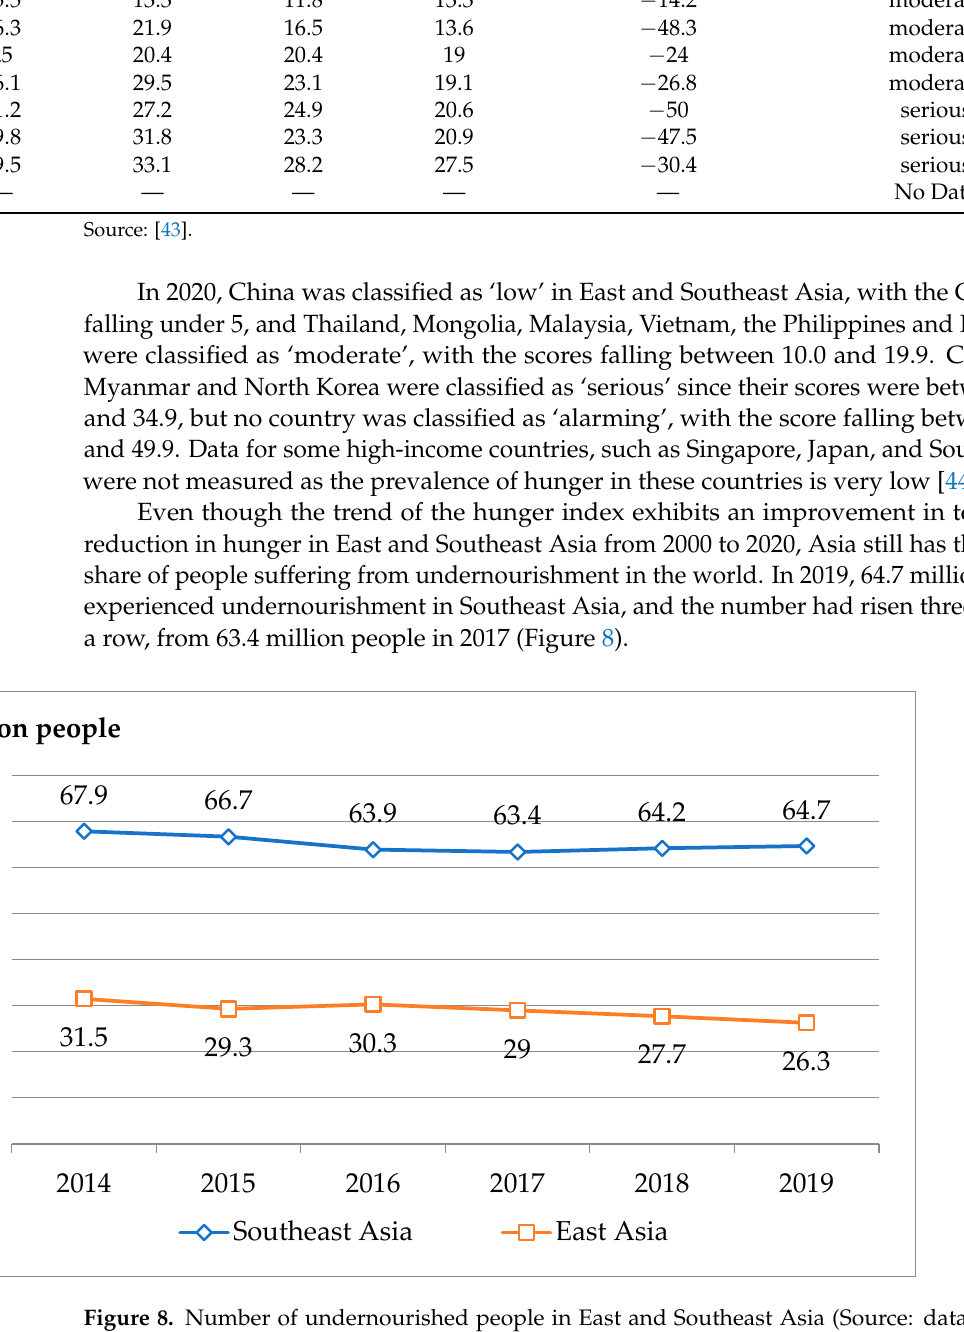
Table 9. Hunger index in East and Southeast Asian Countries.